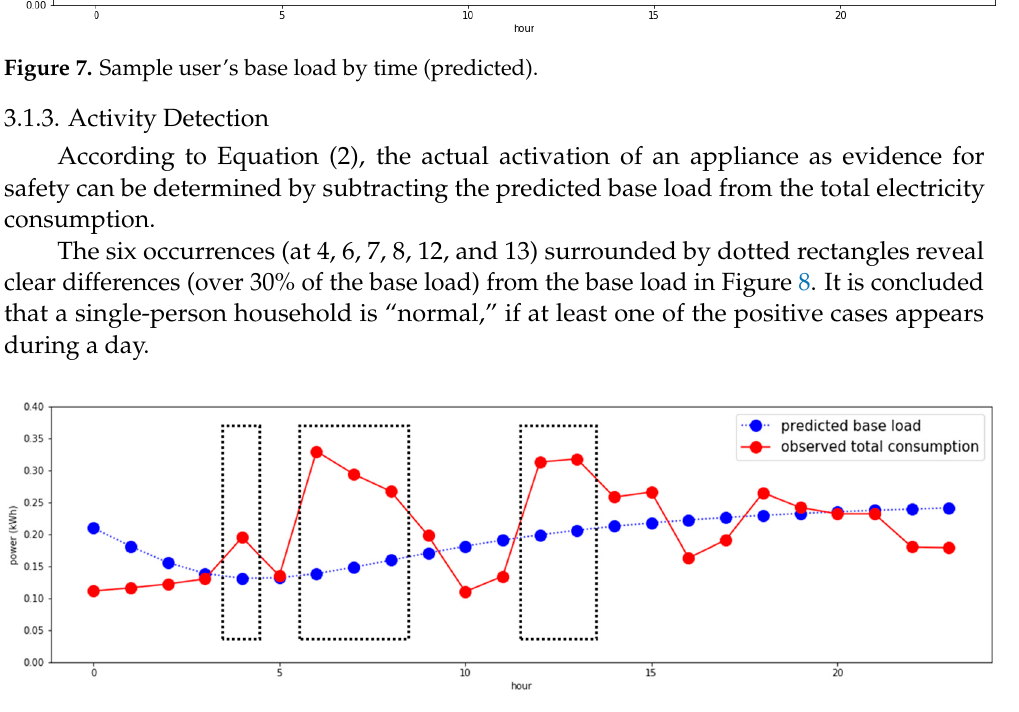
Figure 7. Sample user’s base load by time (predicted).